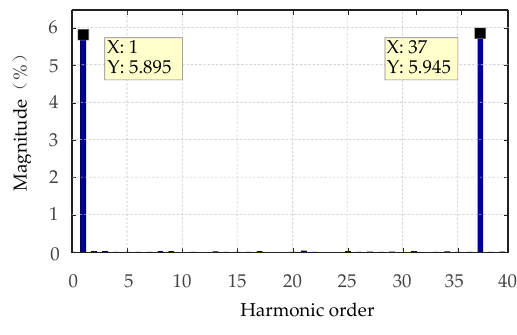
Figure 6. FFT results of V ab .